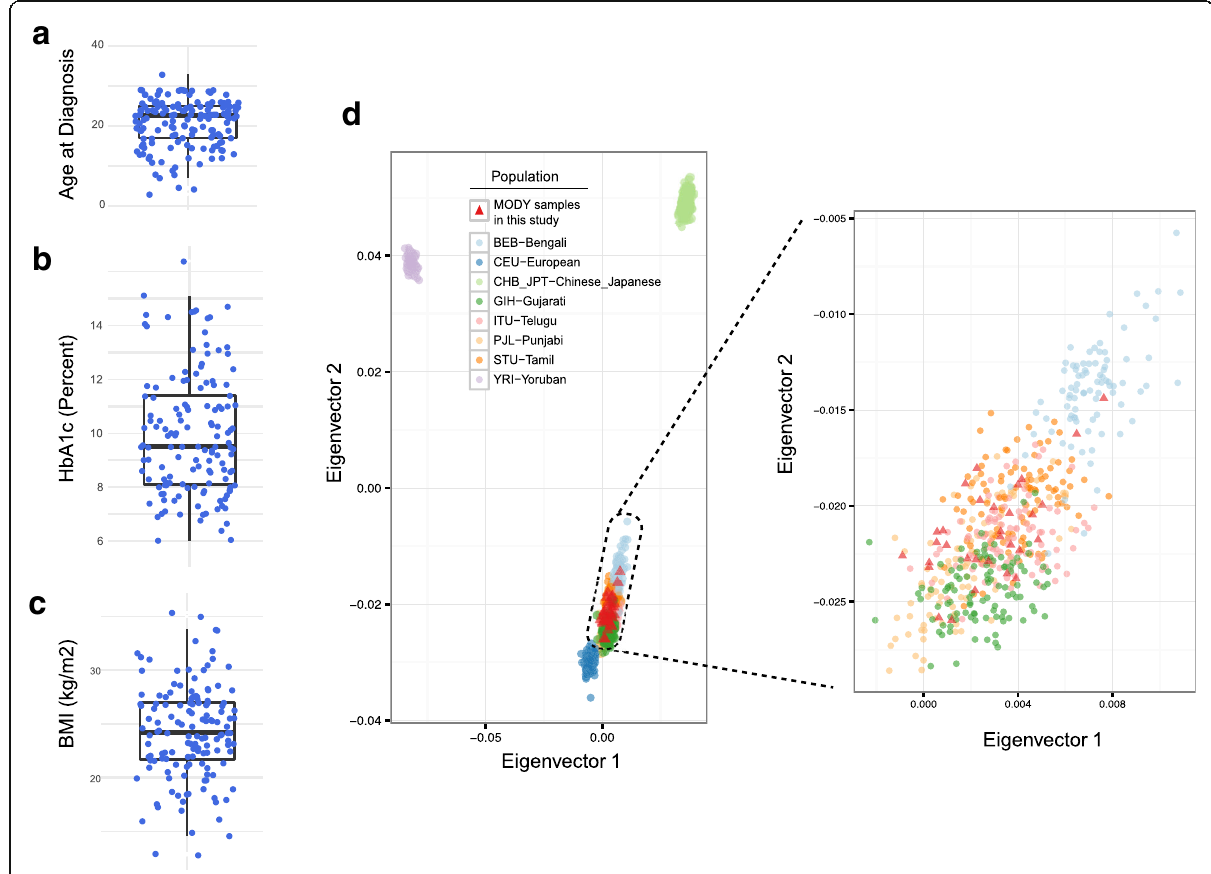
Fig. 1 MODY samples. a-c Box plots of age at ascertainment or diagnosis of diabetes ( a ), HbA1c ( b ) and BMI ( c ) for MODY patients; ( d ) PCA analysis of 31 MODY patient exome samples shown along with samples from 1000 Genomes Phase 3 data. The median value is shown as a line with the whiskers extending from the highest value within 1.5 * IQR of the third quartile to the lowest value within 1.5 * IQR of the first quartile where IQR is the inter-quartile